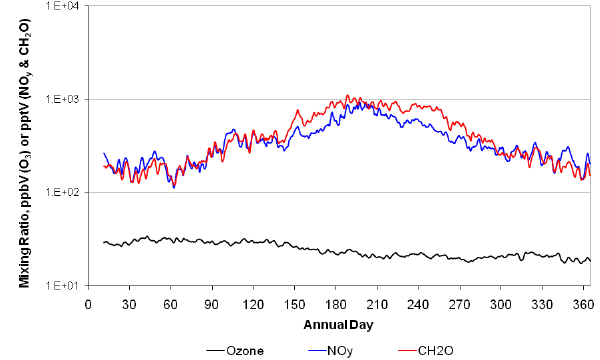
Fig. 2. Grid-averaged time series of three photochemically active species for the natural emissions simulation of 2002. Diurnal noise was removed by applying a 24-hr averaging filter.